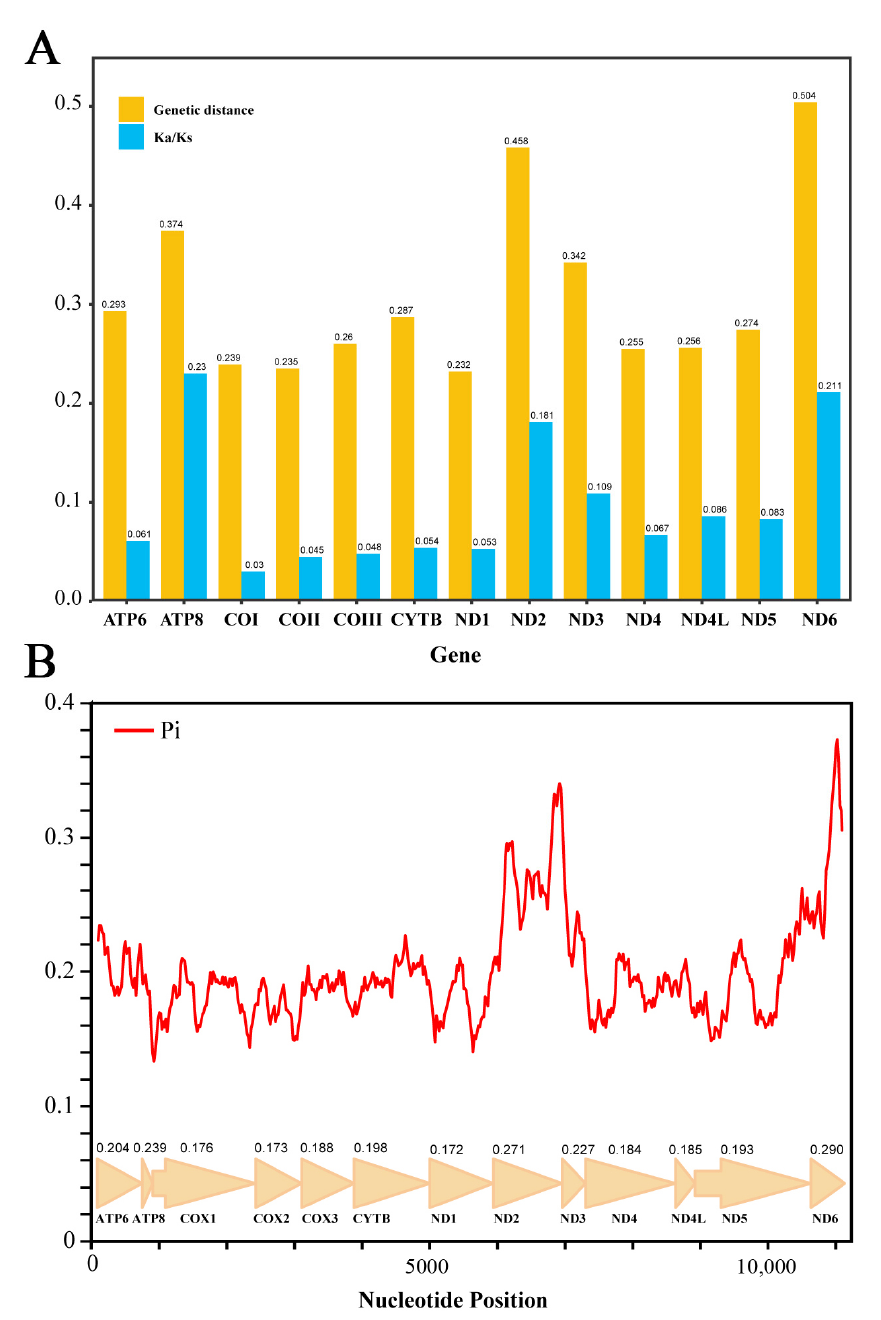
Figure 4. ( A ) Ratio of non-synonymous (Ka) to synonymous (Ks) substitution rates and average genetic distance of 13 PCGs among 21 Epeorus mitogenomes. ( B ) Sliding window analysis of 13 aligned PCGs among 21 Epeorus mitogenomes. The red line shows the value of nucleotide diversity (Pi).